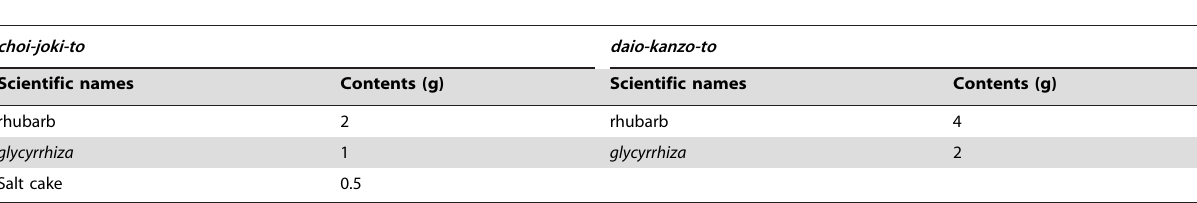
Table 1. Crude drugs constituents of ‘‘ choi-joki-to ’’ and ‘‘ daio-kanzo-to ’’.